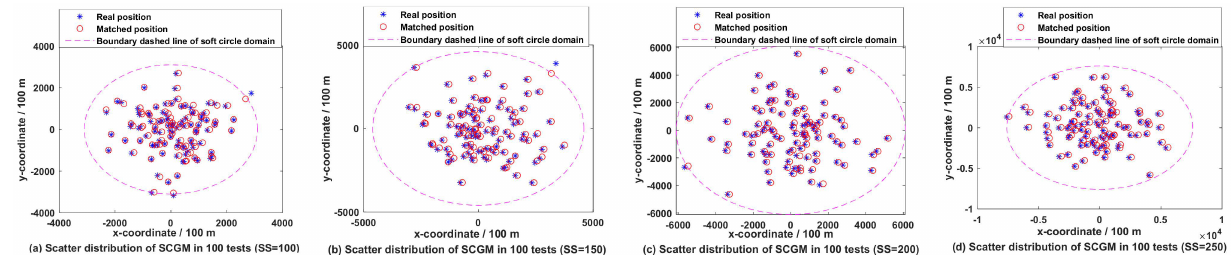
Figure 7. Matching scatter distribution of SCGM under different sampling scales.